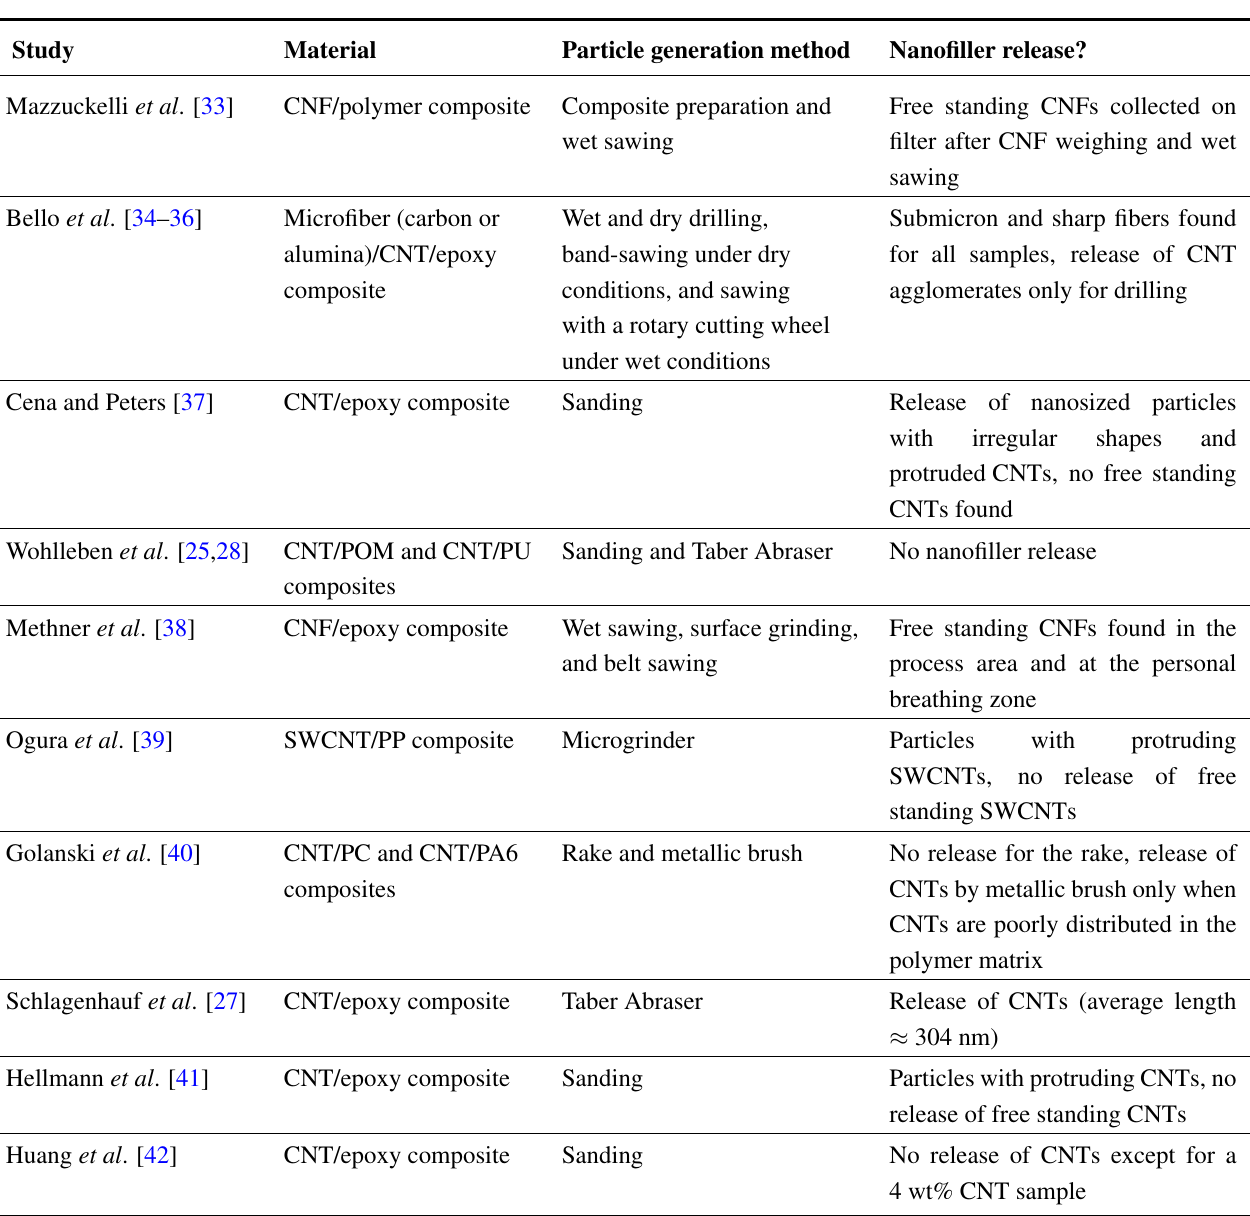
Table 2. Carbon Nanotube (CNT) release studies - Release of particles due to mechanical